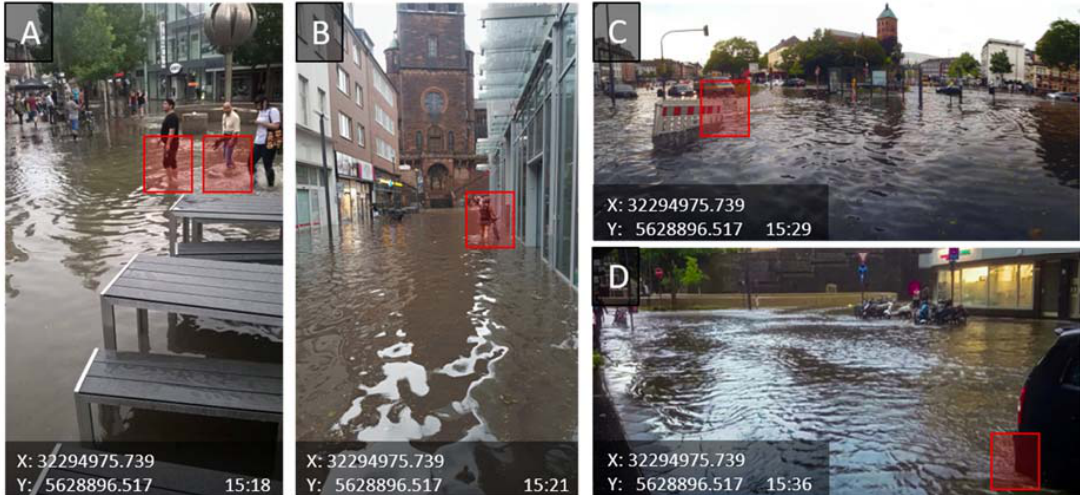
Figure 12. ( a ) Results of the different F5 simulations comparing HP ‐ 1 m 2 simulation results with RT ‐ 5 m 2 and RT ‐ 8 m 2 simulation results in front of water depth estimations from in situ observations. ( b ) Results of the same simulations shown on a 2D ‐ map and highlighted locations of in situ observations.